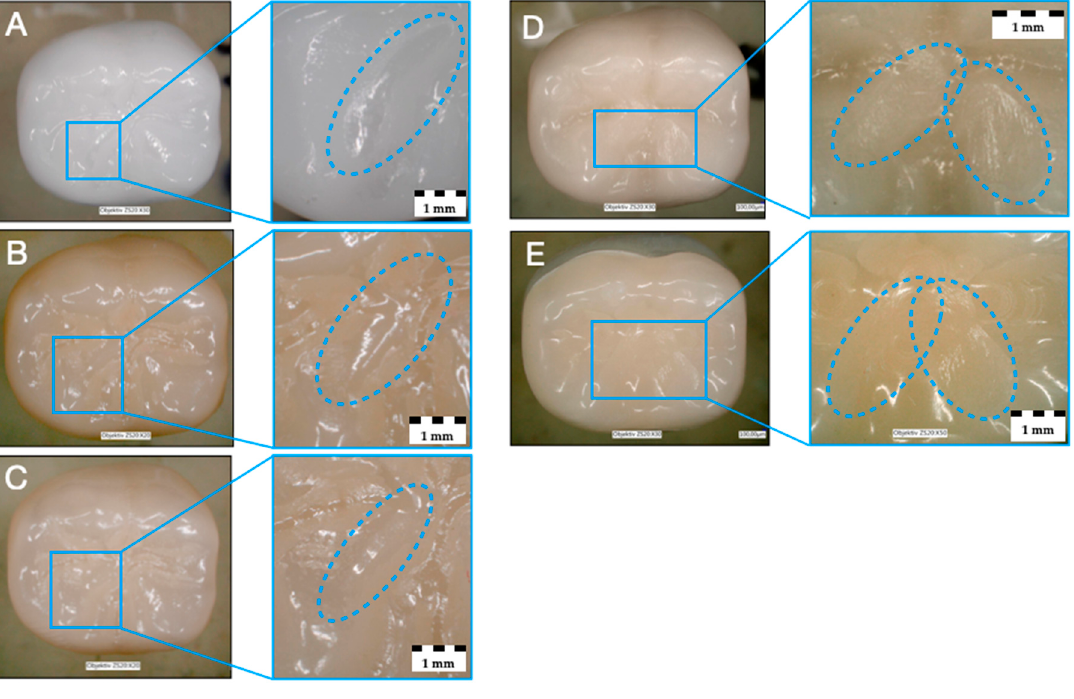
Figure 3. Monolithic zirconia materials after fatigue with superficial and neglectable wear: ( A ) 3Y-TZP (Z-HT), ( B ) 4Y-TZP (Z-ST), ( C ) 5Y-TZP (Z-XT); Materials E ( D ) and RL ( E ) with wear facets after fatigue.